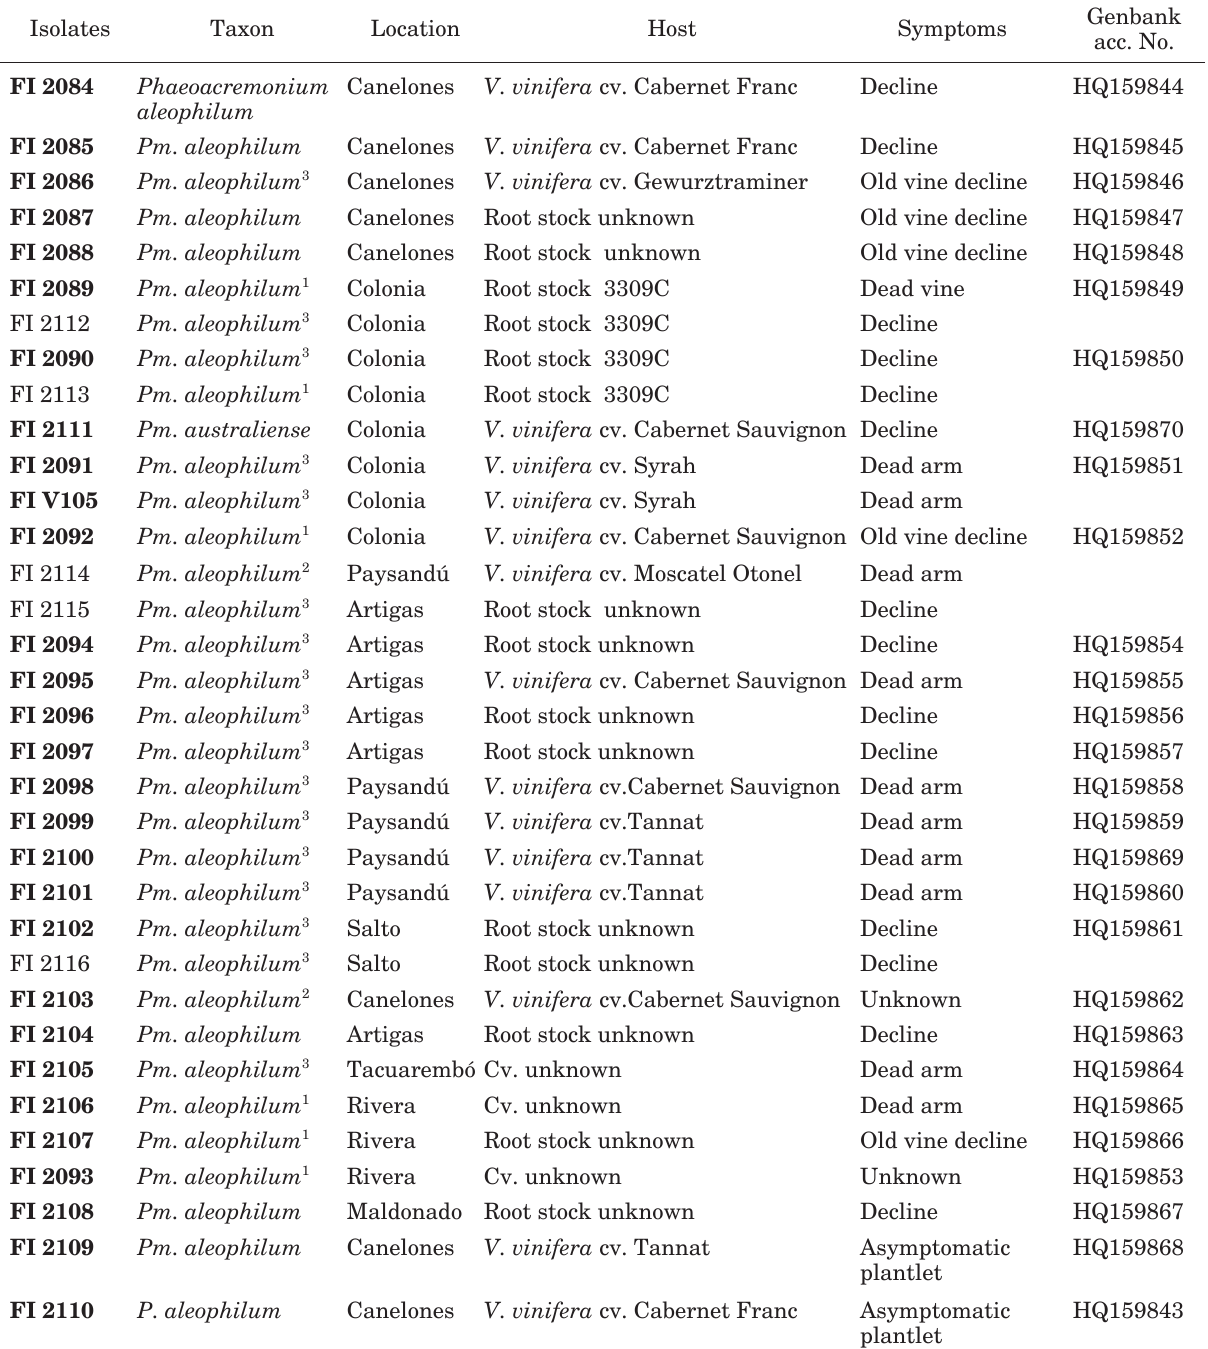
Table 1. Isolates, accession numbers for β -tubulin sequences and location, host and symptom details for Uruguayan Phaeoacremonium spp. included in phylogenetic and morphological studies. Isolates numbers in bold were sequenced for the present